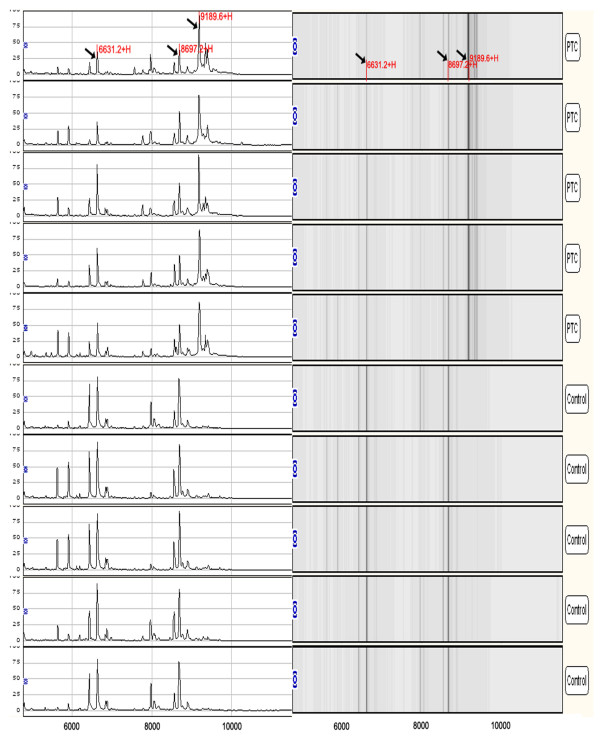
A representative mapping of SELDI-TOF-MS analysis of sera from PTC patients and healthy controls. Differentially expressed proteins with potential diagnostic significance are arrowed. Top-group denotes sera from patients with PTC, in which the protein with m/z of 9190 Da was over-expressed. Bottom-group denotes sera from healthy individuals, in which the proteins with m/z of 6631 and 8697 Da were up-regulated.